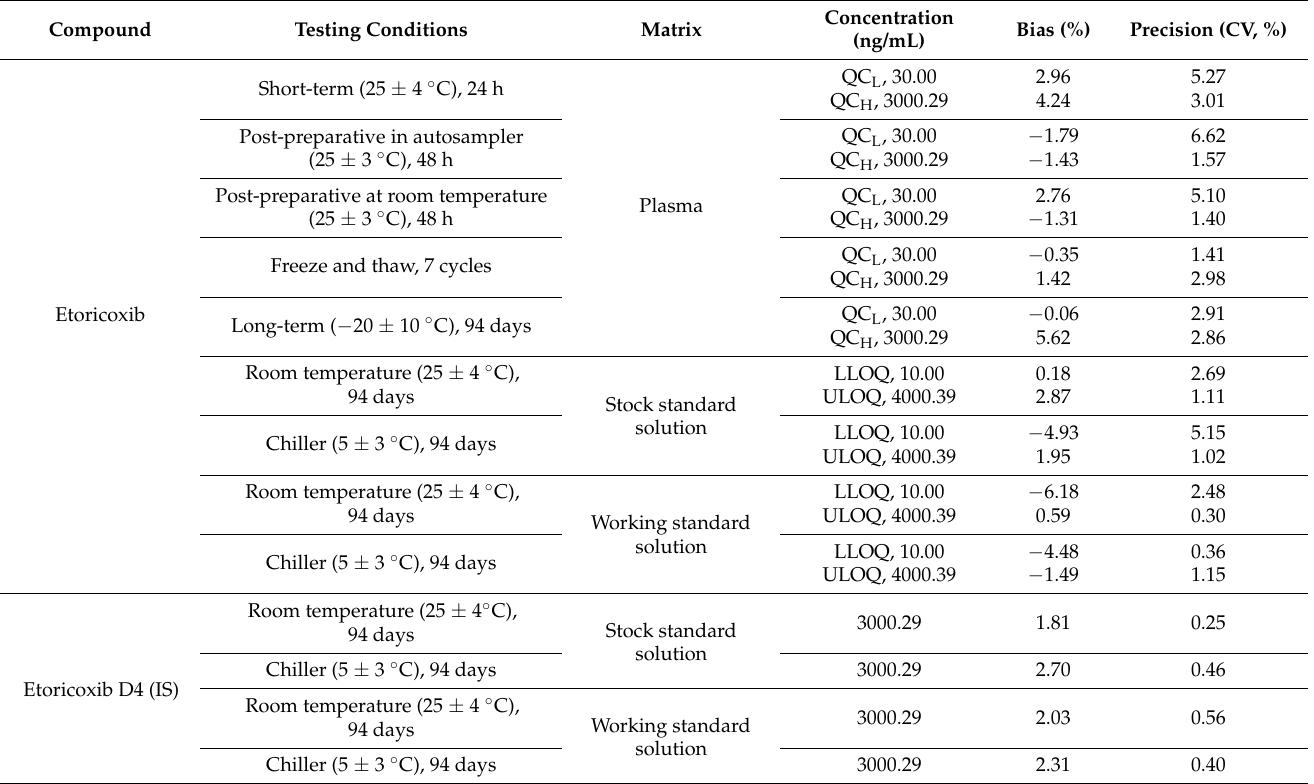
Figure 3. Comparative dissolution profiles between test and reference products for etoricoxib 120 mg Table 5. Stability study results of etoricoxib in human plasma, stock/working standard solution and IS stock/working standard solutions ( n =